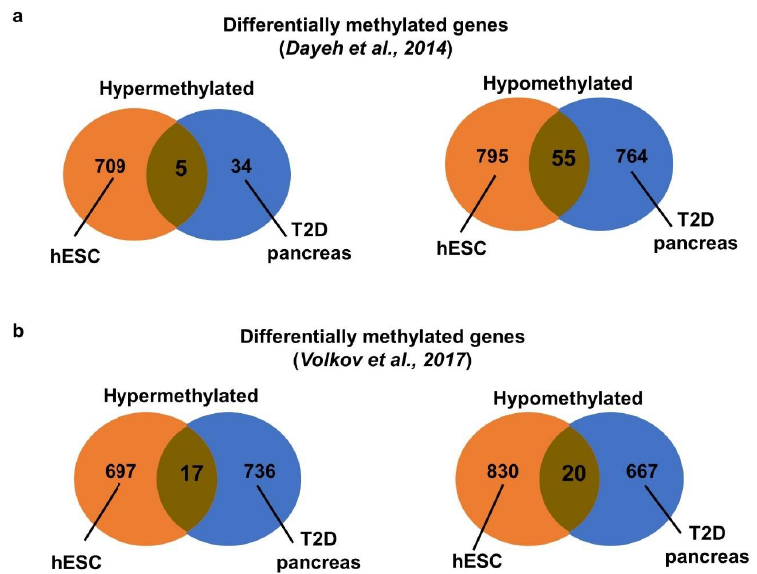
Figure 4. Meta-analysis with dysregulated methylome from pancreatic islets of T2D patients. Venn diagram showing the comparison of hypermethylated and hypomethylated genes between hyperglycemia-treated VAL3 and T2D pancreas from ( a ) Dayeh et al. [7] and ( b ) Volkov et al. [20]. 2.5. Conventional Hyperglycemic Culture Condition Dysregulated Mouse ESC DNA Methylome of Genes Related to Metabolism and Glucose Transport